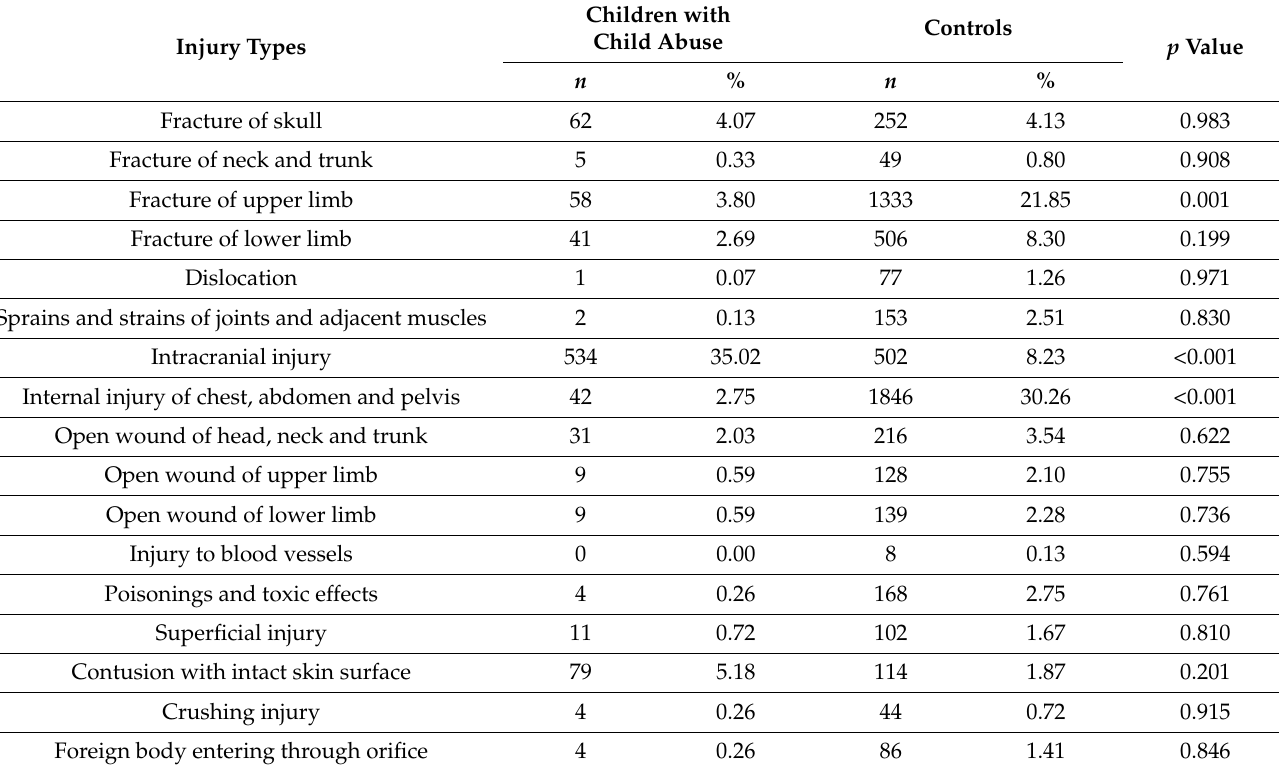
Table 2. Comparison of injury types between children with child abuse and